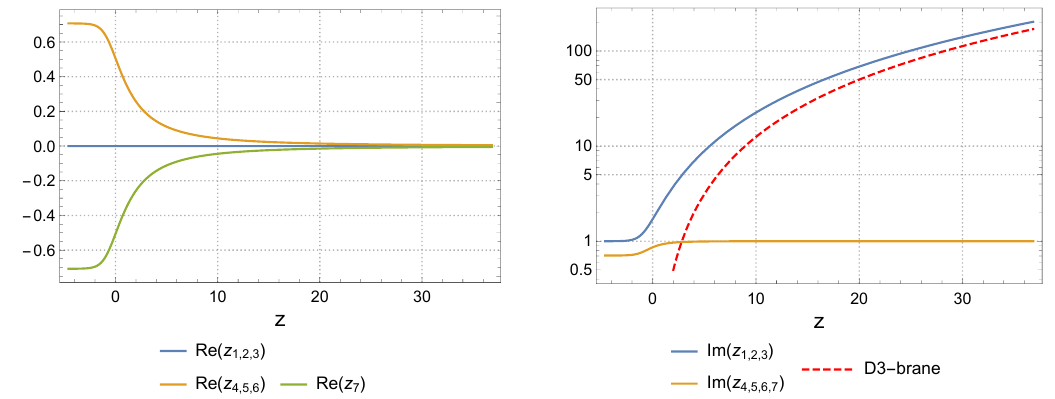
Figure 7 . Holographic RG flow from N = 4 SYM 4 (UV) to N = 4 J-fold CFT 3 (IR) with Λ = − 1 and λ = 0 i